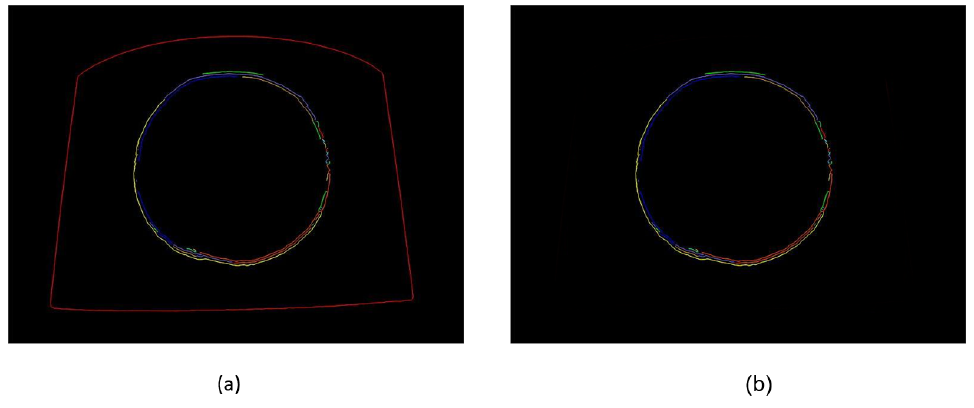
Figure 7. Comparison of two-dimensional weld positioning effects based on Canny and defect regions. ( a ) Edge detection results based on Canny operator. ( b ) Weld extraction result map based on defect